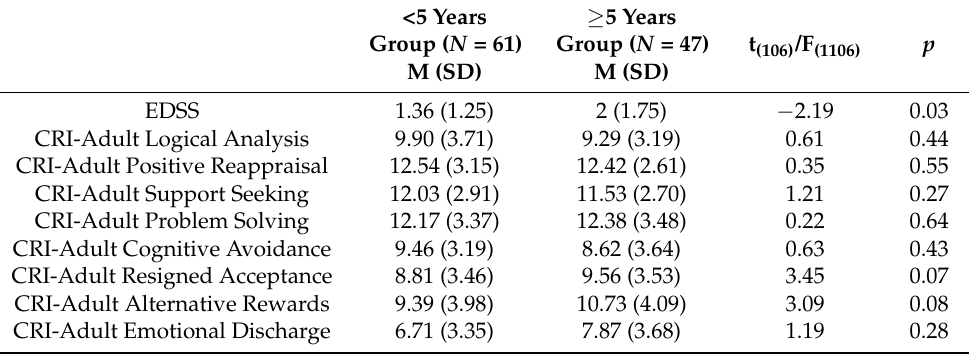
Table 6. Differences between groups (less and more than five years) in coping strategies based on disease